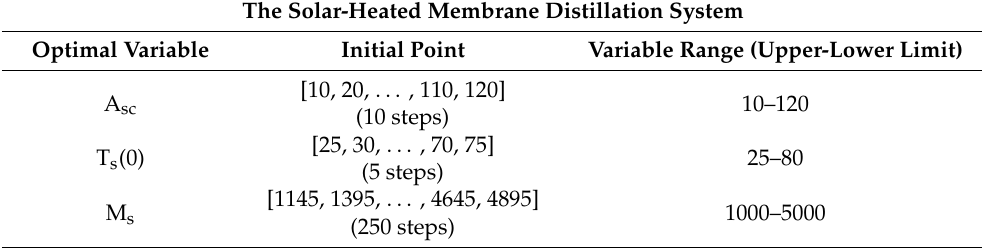
Table 8. The initial point and calculation range of optimization variable for both systems.